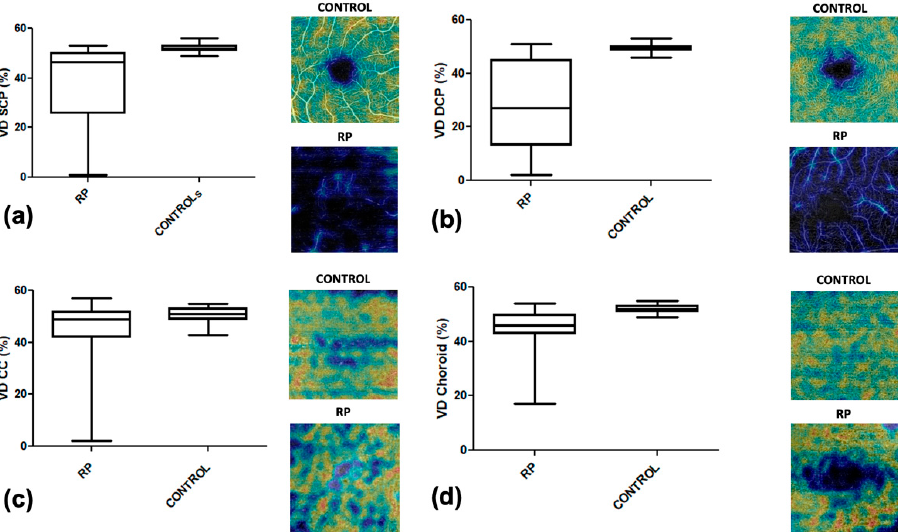
Figure 2. Box plots showing the relationship between controls and retinitis pigmentosa patients of the vascular density in the ( a ) superficial vascular plexus, ( b ) deep capillary plexus, ( c ) choriocapillaris, and ( d ) choroid. Statistically significant differences were observed at all layers.